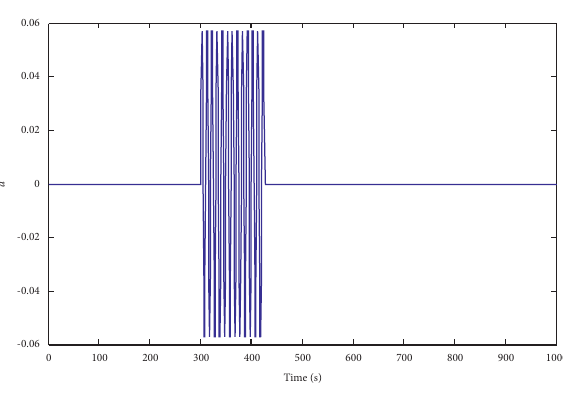
Figure 6: System